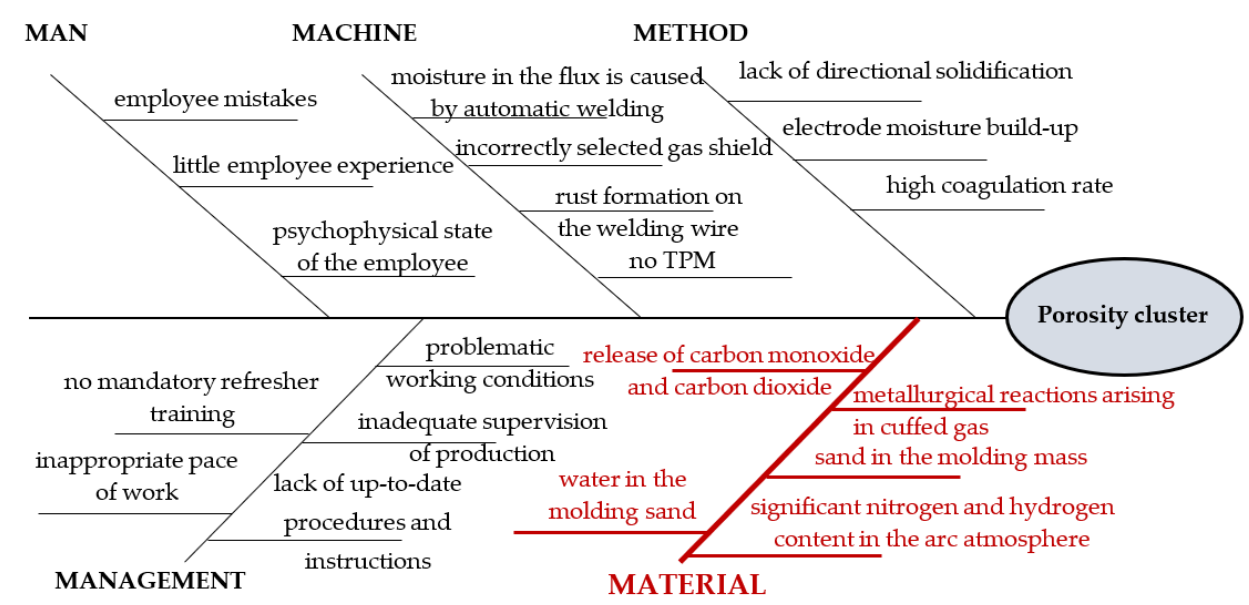
Figure 5. Ishikawa diagram for porosity cluster on mechanical seal.